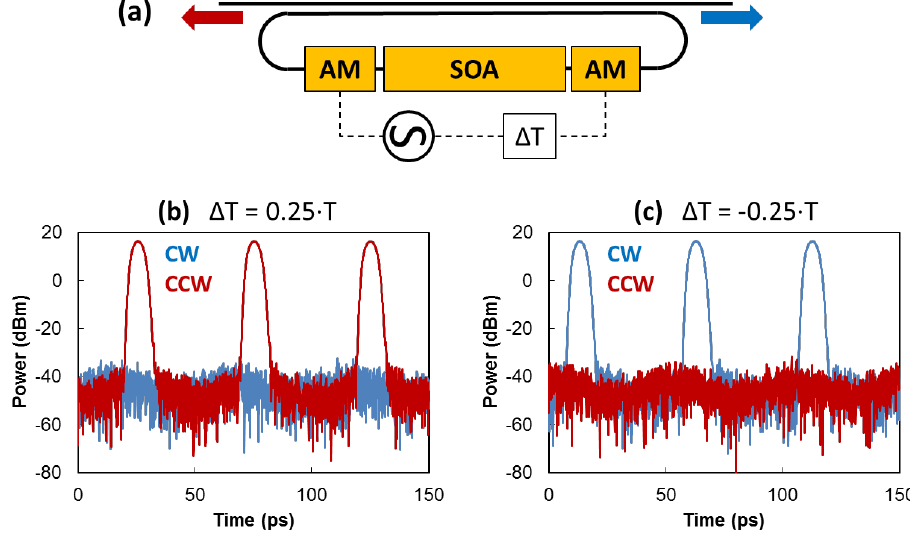
Figure 5. ( a ) Schematic layout of the unidirectional mode-locked laser (MLL), showing an oscillator driving the two AMs, with a relative delay of Δ T . A directional coupler couples light out of the ring into the clockwise (CW, blue) or counterclockwise (CCW, red) output waveguide. The simulated output of a 20-GHz MLL is shown for ( b ) Δ T = 12.5 ps and ( c ) Δ T = −12.5 ps. The SOA length is 800 µm, and the AMs have a length of 25 µm. Power output coupling is 0.5 per roundtrip. The simulation parameters are Δ N tr = 0.7 × 10 18 cm −3 and I SOA = 80